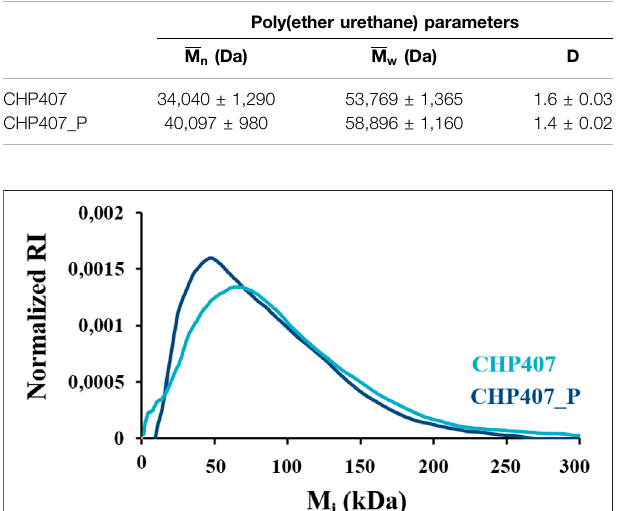
FIGURE 2 | Normalized Refractive Index (RI) signal as a function of molecular weight M i measured for CHP407 (light blue spectrum) and CHP407_P (dark blue